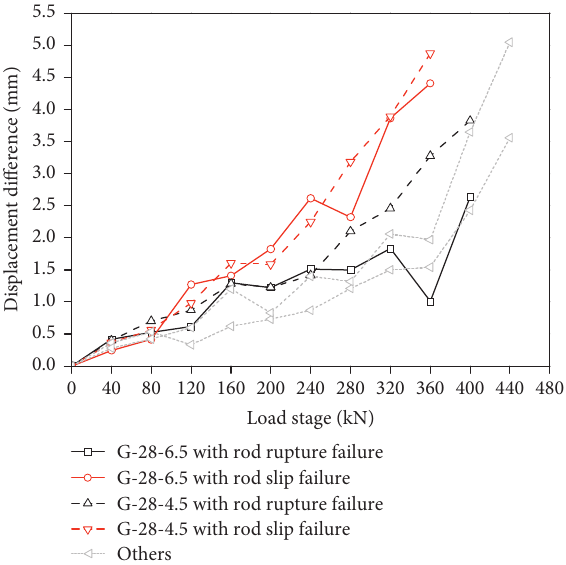
Figure 21: Load-displacement difference curves of the anchors with different anchorage lengths.